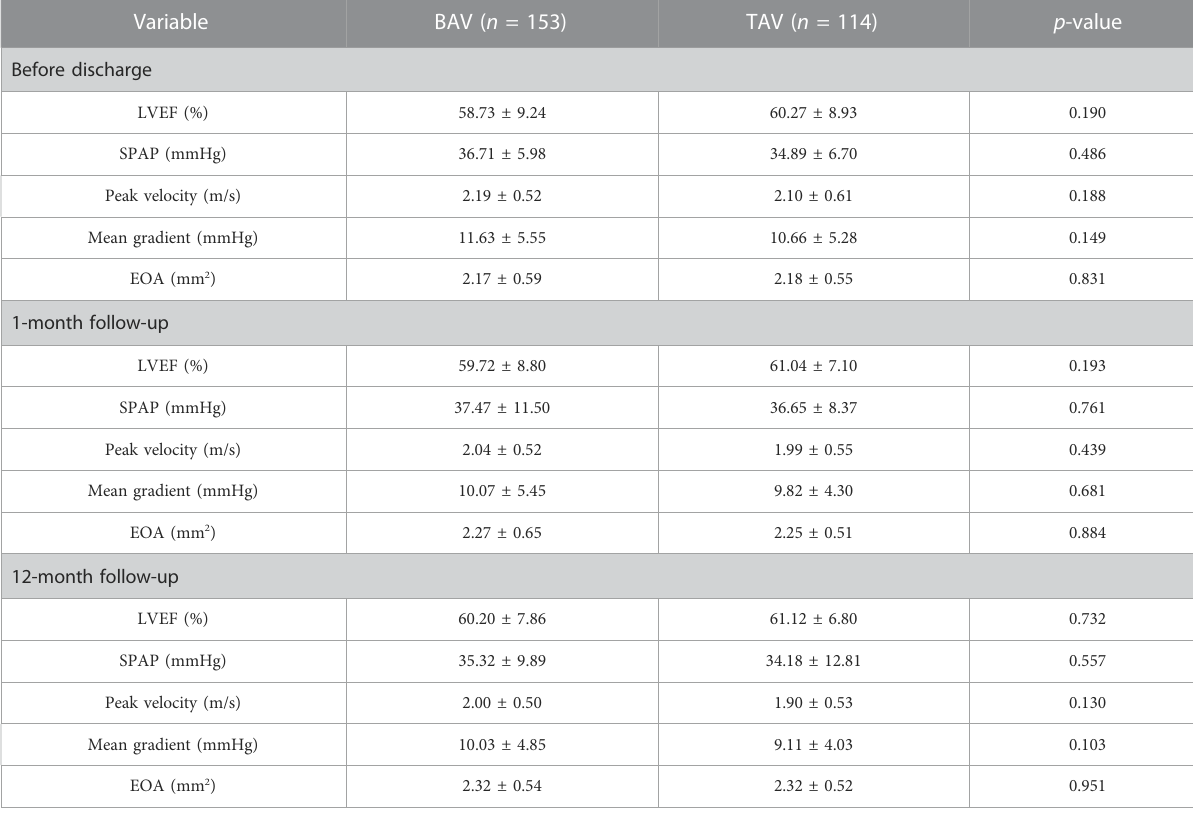
TABLE 2 Haemodynamics before discharge and during